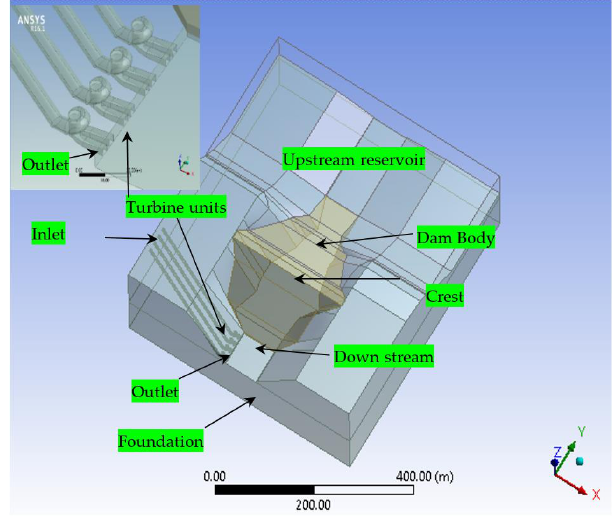
Figure 6. The dam-reservoir-foundation system of Temenggor dam.